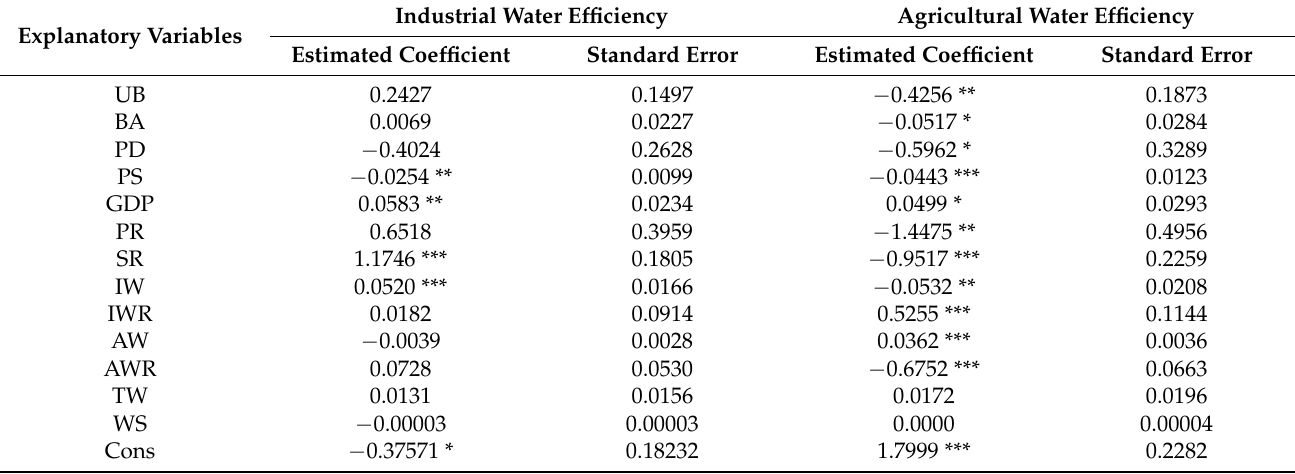
Table 4. Results of Tobit on water use